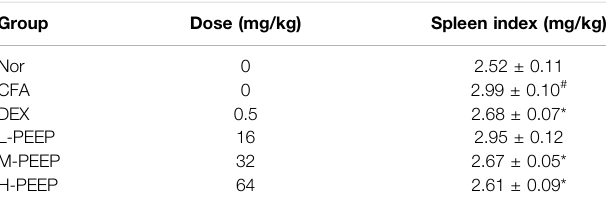
TABLE 3 | The spleen index of CFA